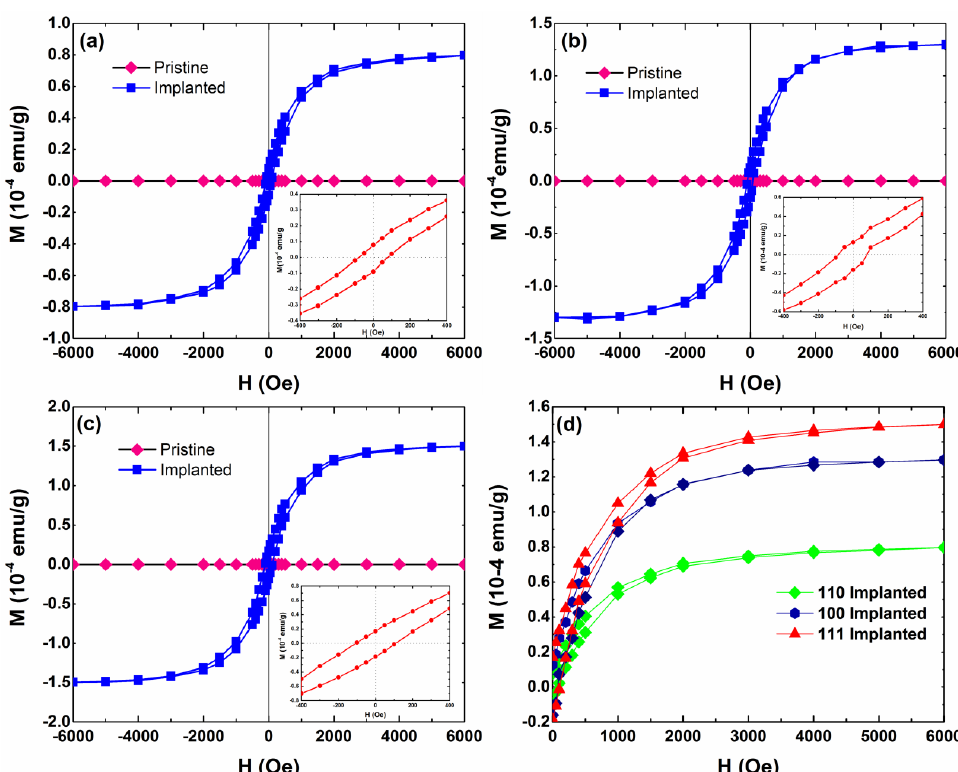
Figure 1. Ferromagnetic hysteresis loops at room temperature for pristine and N + -implanted MgO samples with ( a ) (110) orientation, ( b ) (100) orientation, and ( c ) (111) orientation. The implantation dose of all samples is 2 × 10 17 ions cm −2 ; ( d ) The magnitude of saturation magnetization of MgO samples with the three orientations. The insets in ( a – c ) display a magnified view of the low field data.